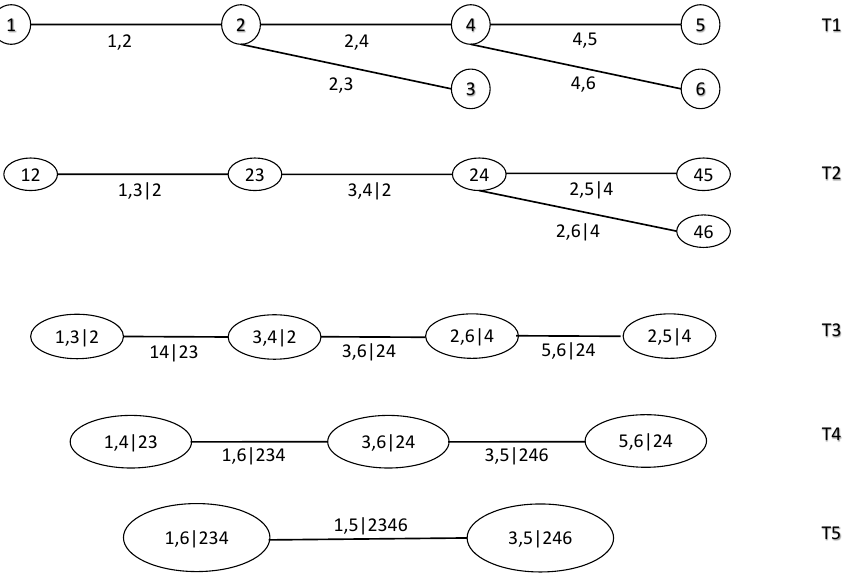
Figure 3. An R-vine with 6 variables, producing 5 trees and 15 edges. Each node represents a variable or a pair of variables, and each edge represents a